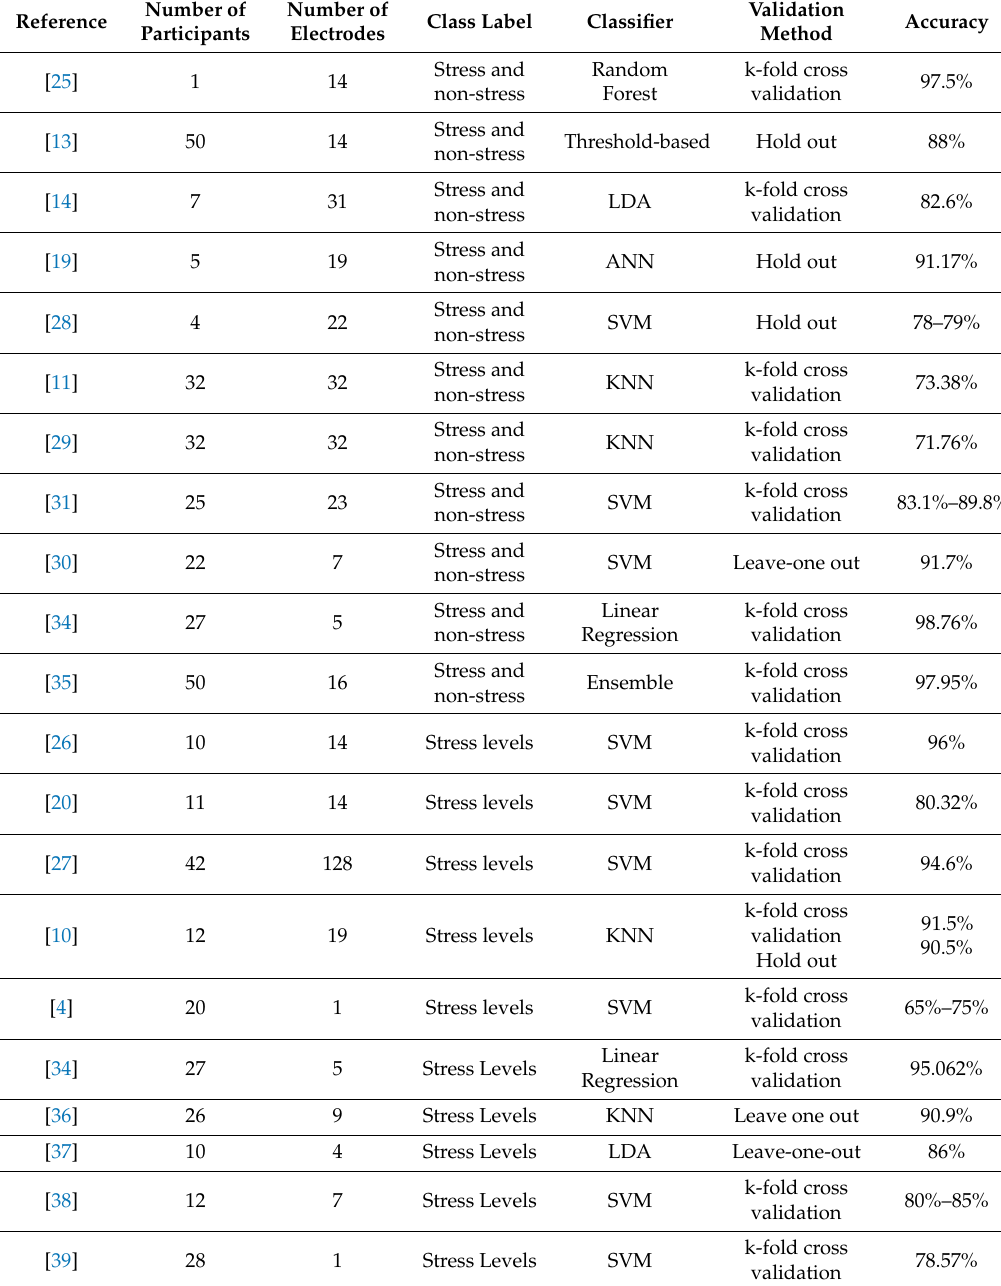
Table 1. A summary of recent techniques from literature that are comparable to the proposed mental stress detection (MSD)